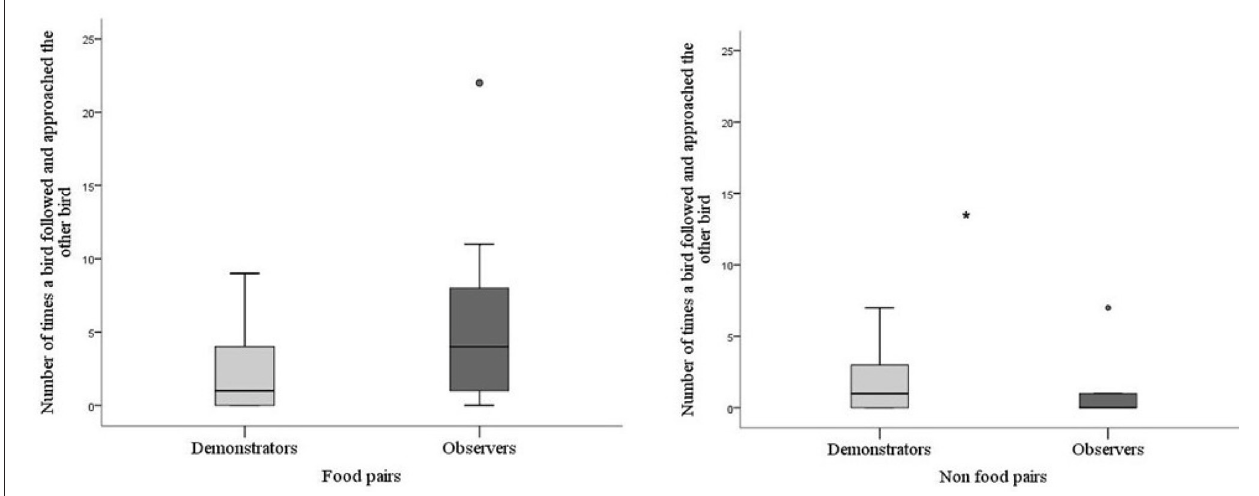
FIGURE 5 | Number of times a bird followed and approached the other bird during testing for batch 2. Thick horizontal lines indicates median nr of pecks, boxes span from the first to the third quartiles and the whiskers represent 95% confidence interval; outliers are denoted by dots. Demonstrators ( N = 14) are the light gray bar and observers ( N = 14) dark gray bar. The asterisk indicates a significant difference between